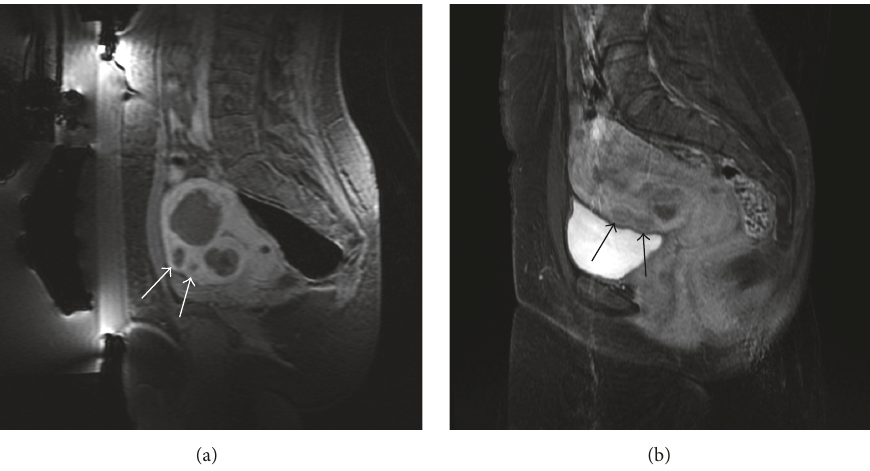
Figure 3: Case 1 : (a) sagittal T1-w with fat saturation acquired after intravenous injection of paramagnetic contrast medium showing the two small fibroids (white arrows) located in the near field that were not directly treated but that became nonperfused too after the treatment; two bigger fibroids treated are visible too; (b) a follow-up MRI (T1-w with fat saturation acquired after intravenous injection of paramagnetic contrast medium) showing a normal vascularization of the two small fibroids.